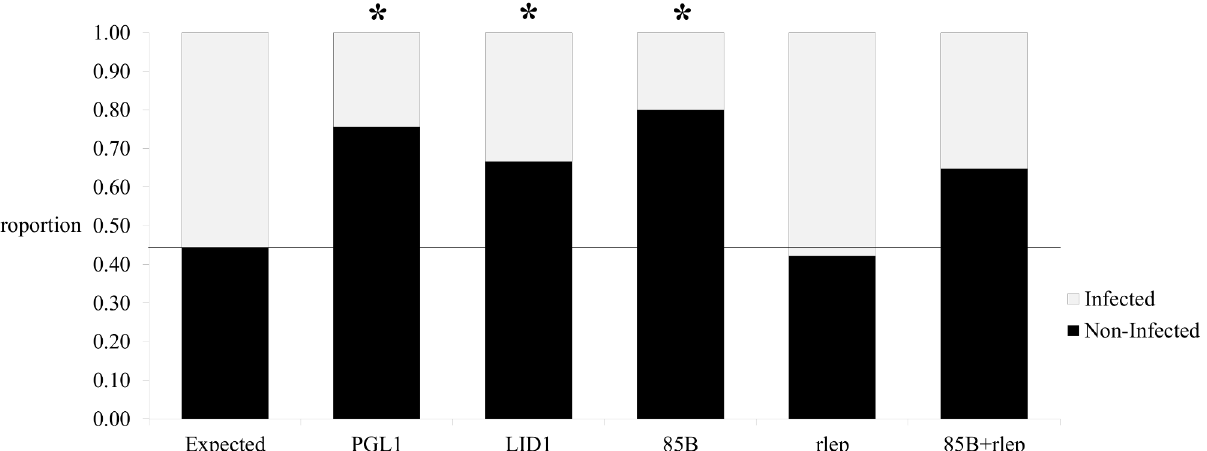
Fig 1. Goodness of fit analysis for trial study. ELISA and qPCR test results for the armadillo trial study as compared to the expected results based on known armadillo experimental infection statuses (infected n = 25, non-infected n = 20). Each assay type is compared to the expected using Chi-squared analyses. Assay types include the PGL1 ELISA (infected n = 11, non-infected n = 34, χ 2 = 17.52, p < 0.01), LID1 ELISA (infected n = 15, non-infected n = 30, χ 2 = 8.92, p < 0.01), 85B qPCR (infected n = 9, non-infected n = 36, χ 2 = 22.90, p < 0.01), rlep qPCR (infected n = 26, non-infected n = 19, χ 2 = 0.12, p = 0.73), and combination of 85B and rlep qPCRs (85B+rlep, infected n = 18, non-infected n = 27, χ 2 = 4.36, p = 0.04). Chi-squared analyses show all tests significantly differ from the expected ( * p < 0.01) except the qPCR tests performed using only the rlep target and the combination of 85B and rlep.